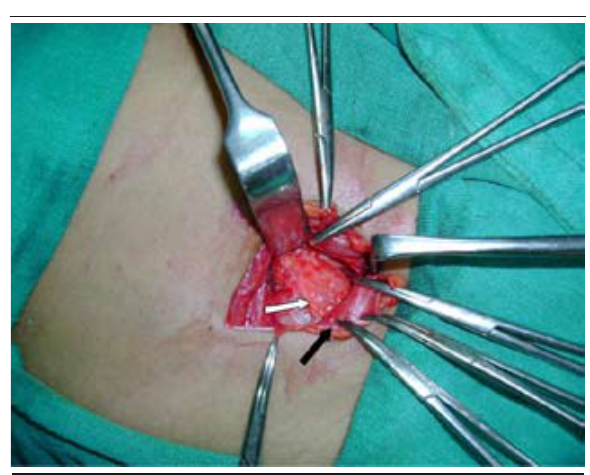
Figure 2. Operative photograph showing a thick hernia sac and extraperitoneal fatty tissue (white block arrow) entering the femoral canal. the inguinal ligament is reflected inferiorly (black block